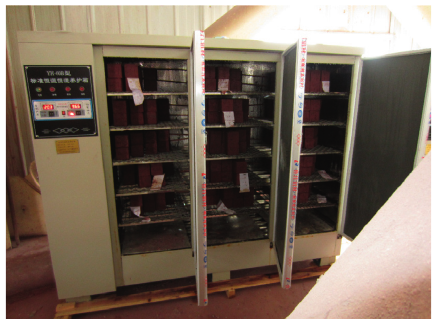
Figure 2: Curing of constant temperature and humidity test block for filling body.